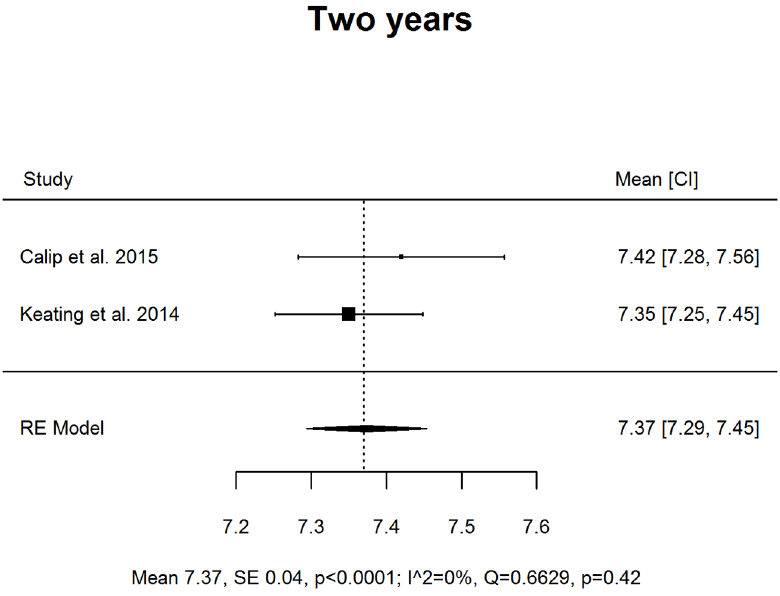
Fig 4. Forest plot of studies considering mean HbA1c levels (%) at 24 months post time of cancer diagnosis and treatment initiation.